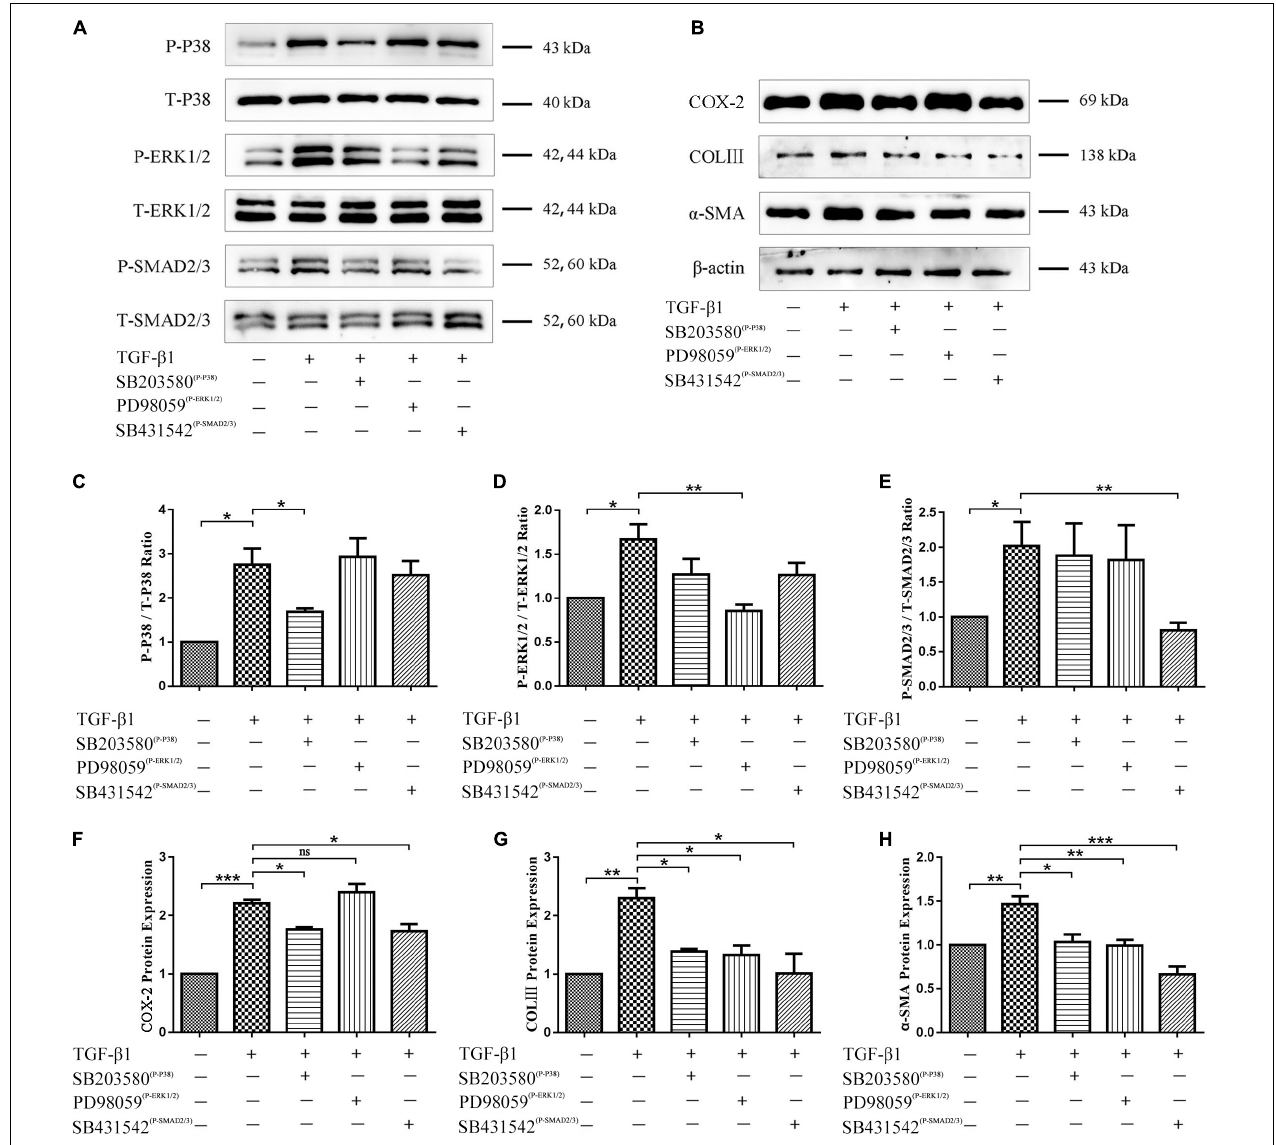
FIGURE 6 | Role of p38 MAPK, ERK1/2, and Smad2/3 signaling in TGF- β 1-induced inflammatory and fibrotic fibroblast functions. (A) Western blots confirming inhibition of p38 MAPK, ERK1/2, and Smad2/3 signaling pathways by SB203580, PD98059, and SB431542. (B) Western blots demonstrating levels of COX-2, COLIII, and α -SMA after inhibition of p38 MAPK, ERK1/2, and Smad2/3 signaling pathways. Quantitation of (C) phospho-p38 MAPK, (D) phospho-ERK1/2, (E) phospho-Smad2/3, (F) COX-2, (G) COL III, (H) α -SMA proportions ( n = 3). Data are represented as mean ± SD. * P < 0.05, ** P < 0.01, *** P <